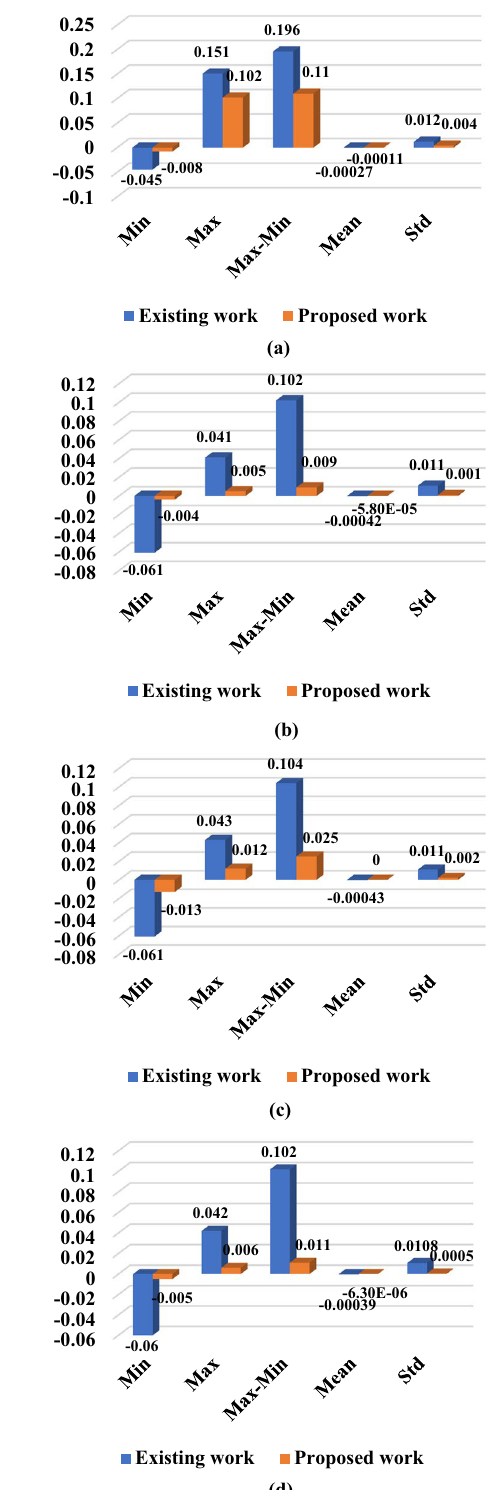
Fig. 22 Statistical analysis for frequency deviation (Hz): a Case 1,